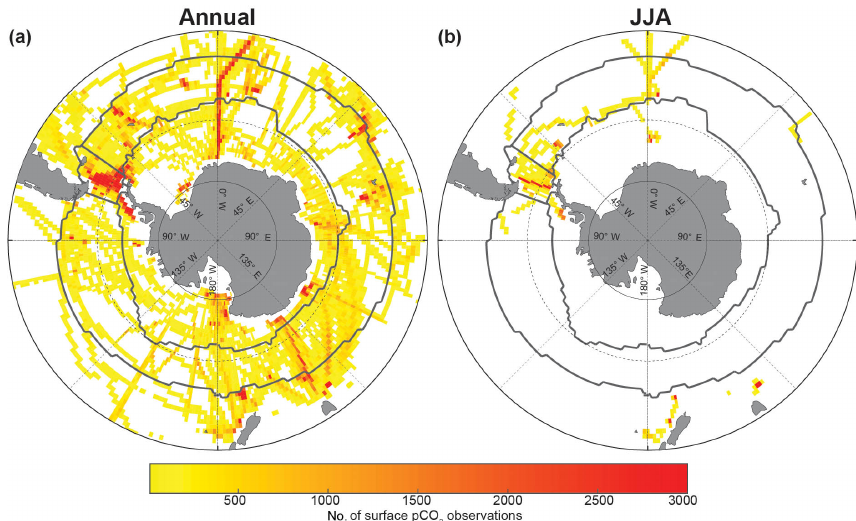
Figure 3. Data density of p CO 2 observations from the SOCATv5 dataset within each 1 ◦ × 1 ◦ grid cell. Data are restricted to years 2002– 2016. Salinity values outside of 33.5–34.5psu and observations within 50km of land are omitted. (a) Data from all months of the year; (b) data from only June, July, and August (austral winter). Gray lines designate the boundary of the SPSS biome and the Drake Passage region for